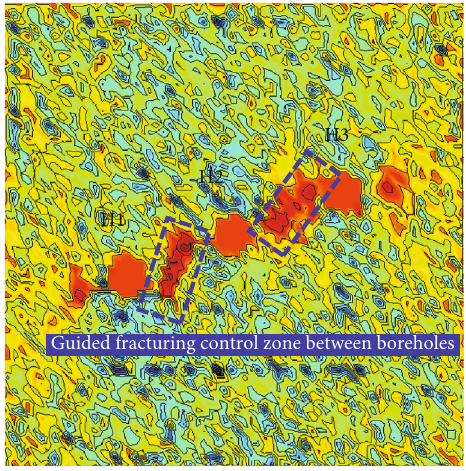
Figure 12: The shape and distribution of the guided fracturing control zone between